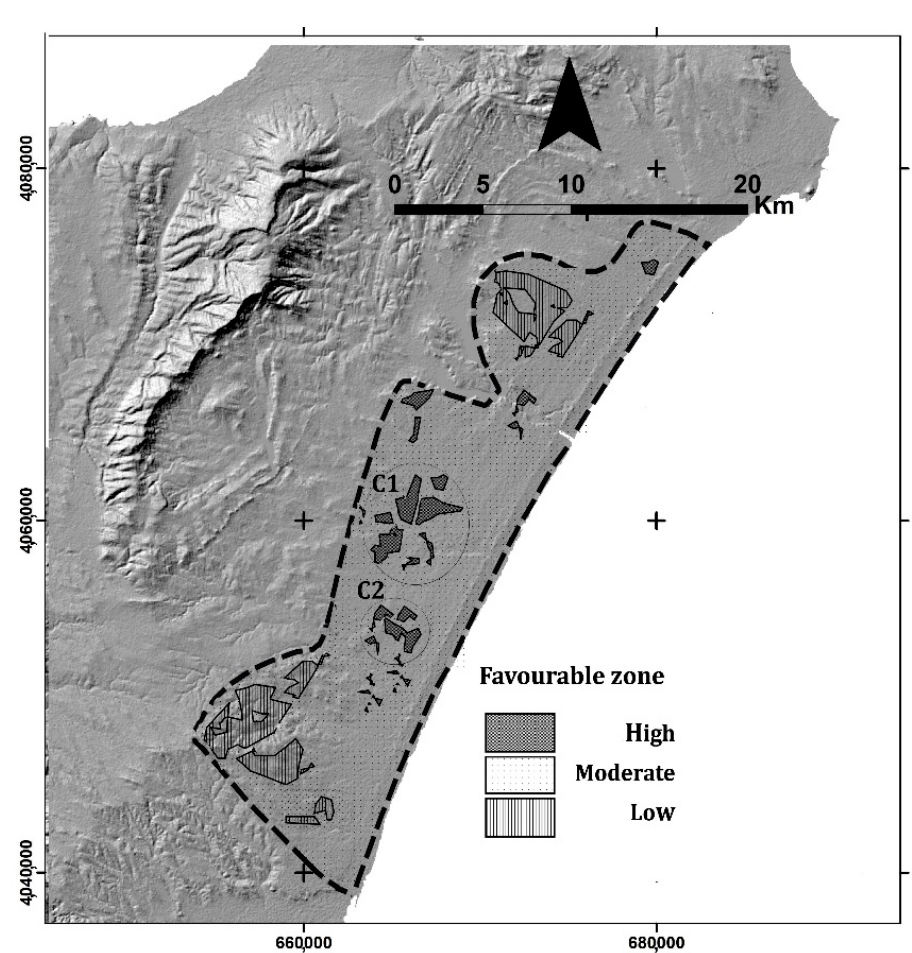
Figure 7. Map of Korba artificial recharge areas showing two clusters (C1 and C2) of highly favorable zones.